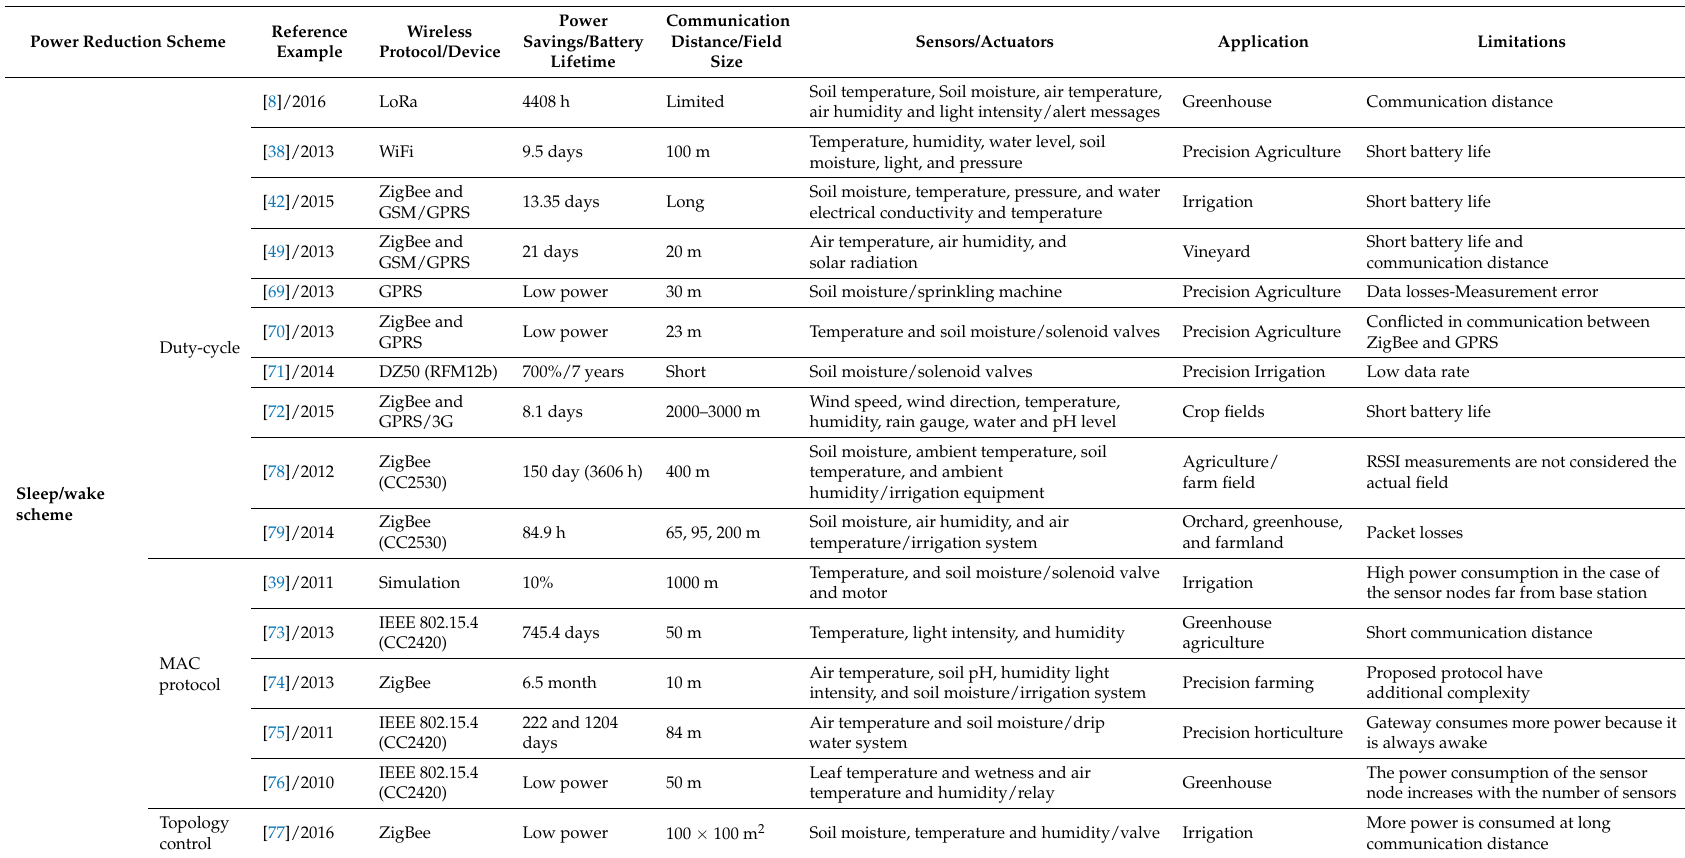
Table 2. Sleep/wake schemes for previous research in agricultural